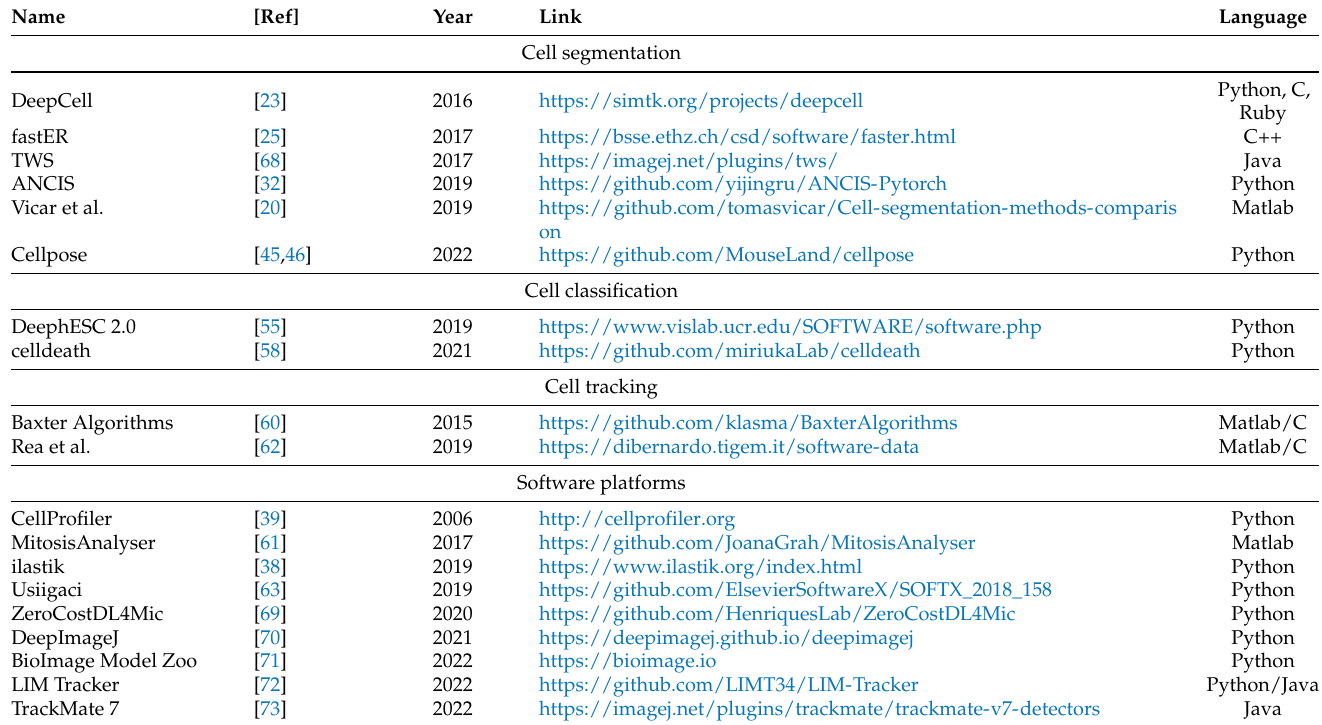
Table 1. Software: name (Name); reference ([Ref]); year of publication (Year); url (Link); programming language or environment (Language). All links were accessed on 28 August